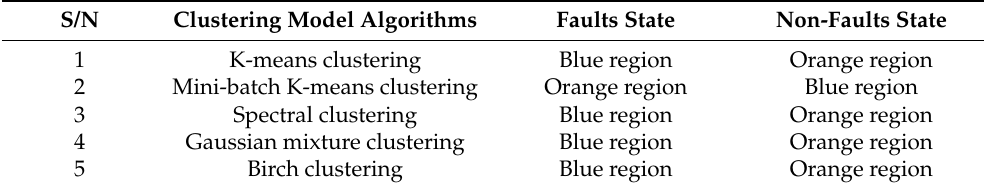
Table 2. Comparison of the simulated results for the different clustering model algorithms when two clusters are considered. S/N Clustering Model Algorithms Faults State Non-Faults State K-means clustering Blue region Mini-batch K-means clustering Gaussian mixture clustering Blue region Orange region Birch clustering Blue region Orange